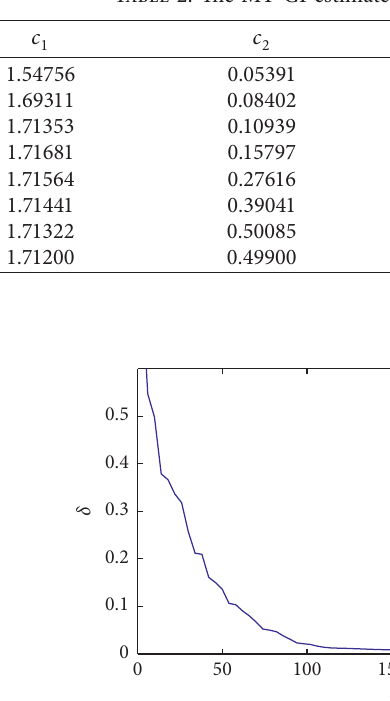
Figure 1: The parameter estimation errors δ versus t